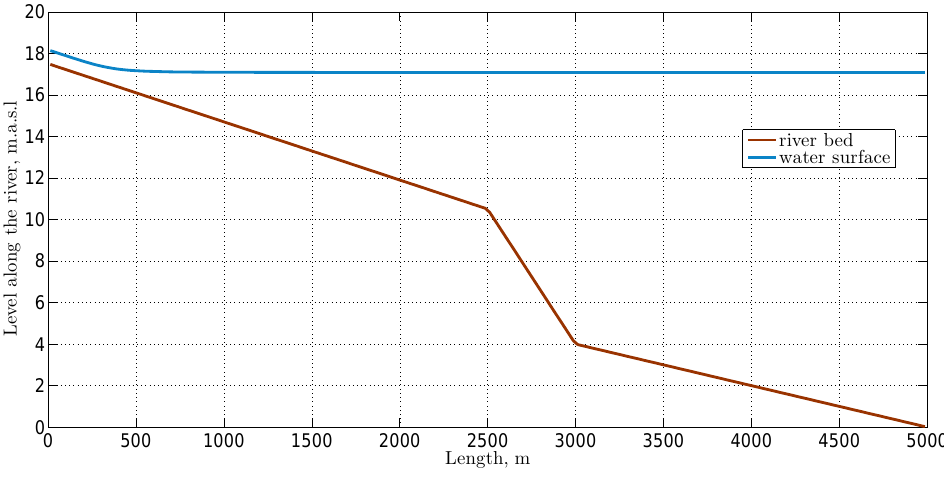
Figure 2: The schematic view of the river